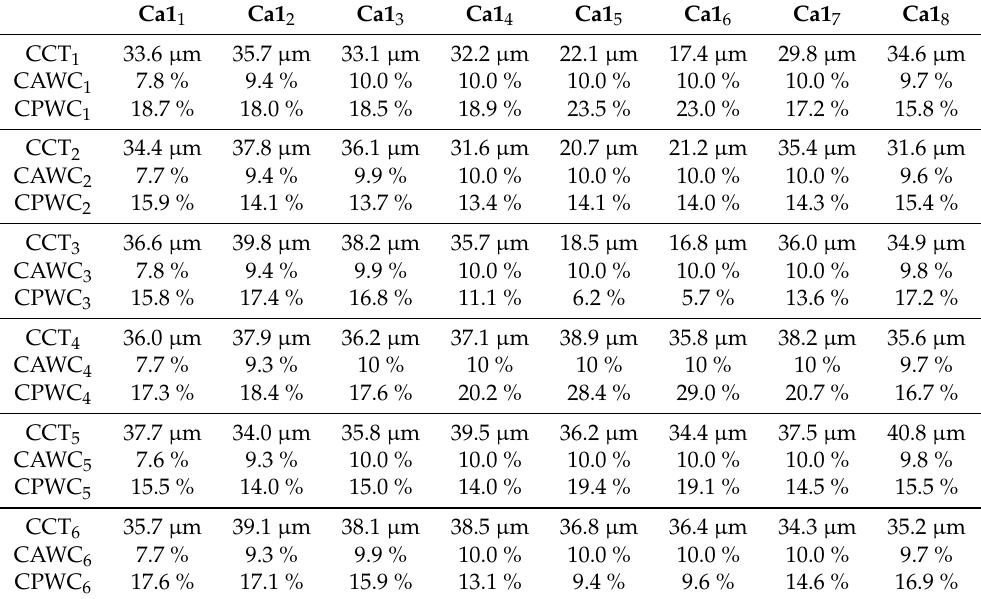
Table 4. RMSD of estimated CCT, CAWC, and CPWC for six noisy cornea calibrated with various noisy perturbed PEC sphere at frequency band of WR 2.2. The SNR 60 dB is